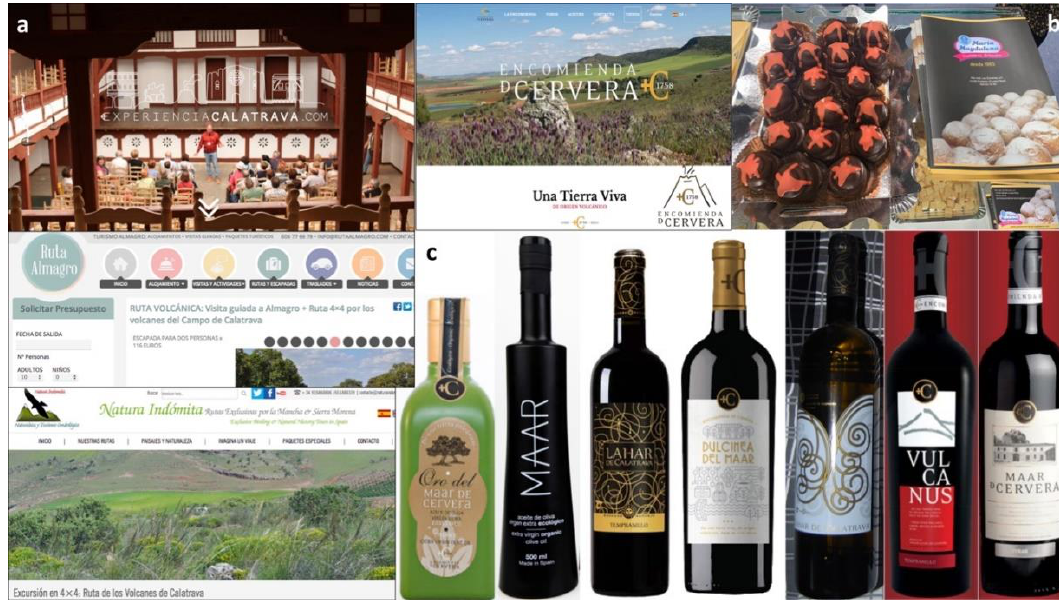
Figure 18. ( a ) Local active tourism companies’ websites offering volcano tourism; ( b ) Magmitos (“little magmas”); ( c ) examples of local “volcanic” oils and wines.